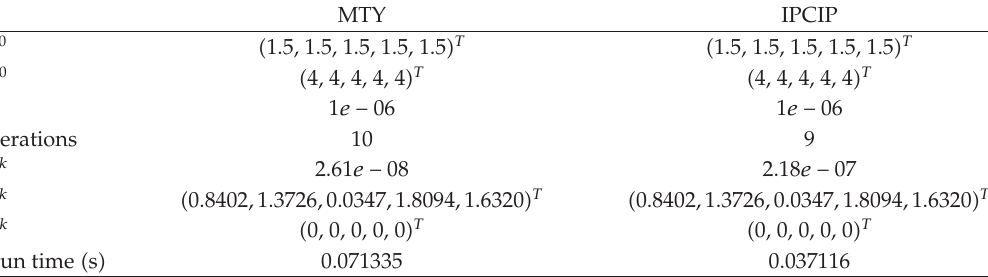
Table 2: Computational results of test problem 2.